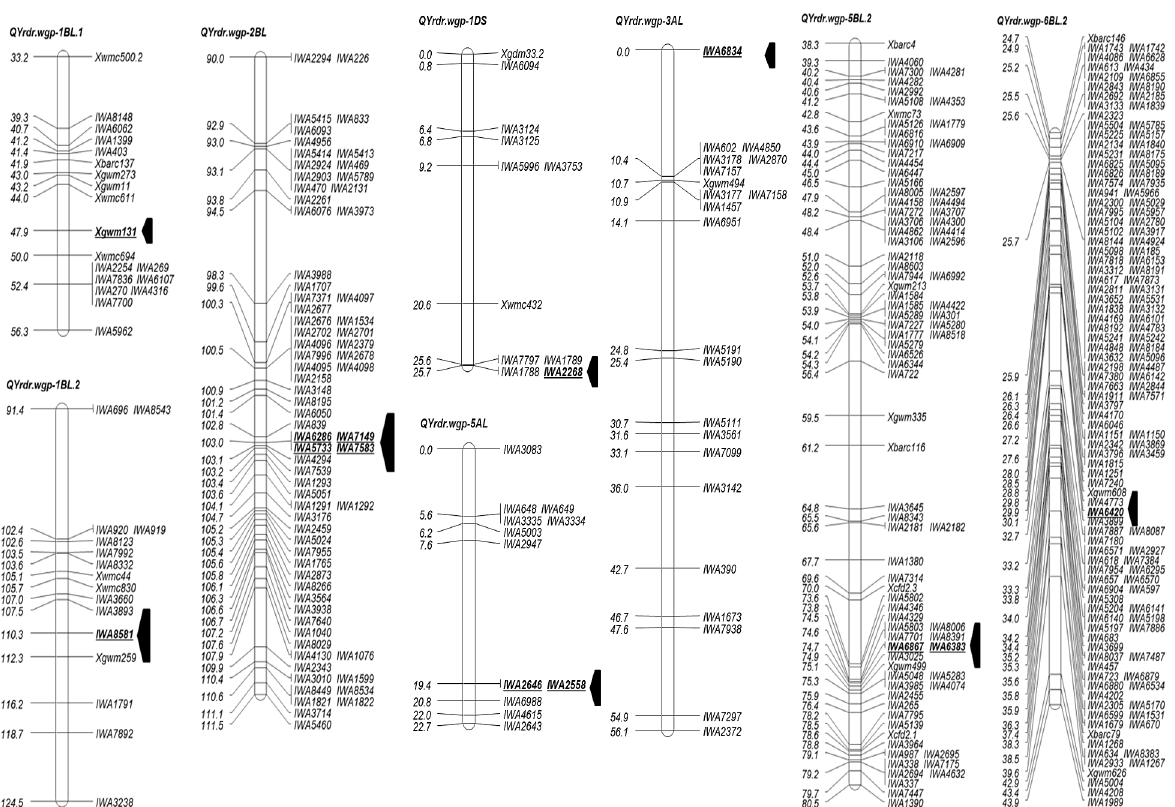
Fig 4. Linkage maps for high-temperature adult-plant (HTAP) resistance eight QTL identified in the Druchamp × Michigan Amber derived recombinant inbred line population using stripe rust phenotypic data obtained under various environments and genotypic data of simple sequence repeat (SSR) and single nucleotide polymorphism (SNP) markers. A total of eight linkage maps were identified. Fig 4.1 shows QTL QYrdr . wgp-1BL . 1 , QYrdr . wgp-1BL . 2 and QYrdr . wgp-2BL ; Fig 4.2 shows QYrdr . wgp-1DS , QYrdr . wgp-3AL , and QYrdr . wgp-5AL ; and Fig 4.3 shows QYrdr . wgp- 5BL . 2 and QYrdr . wgp-6BL . 2 . Markers with prefix X are SSR markers and those with prefix IWA ) are SNPs. The locations of the QTL are indicated by the arrows and the markers in